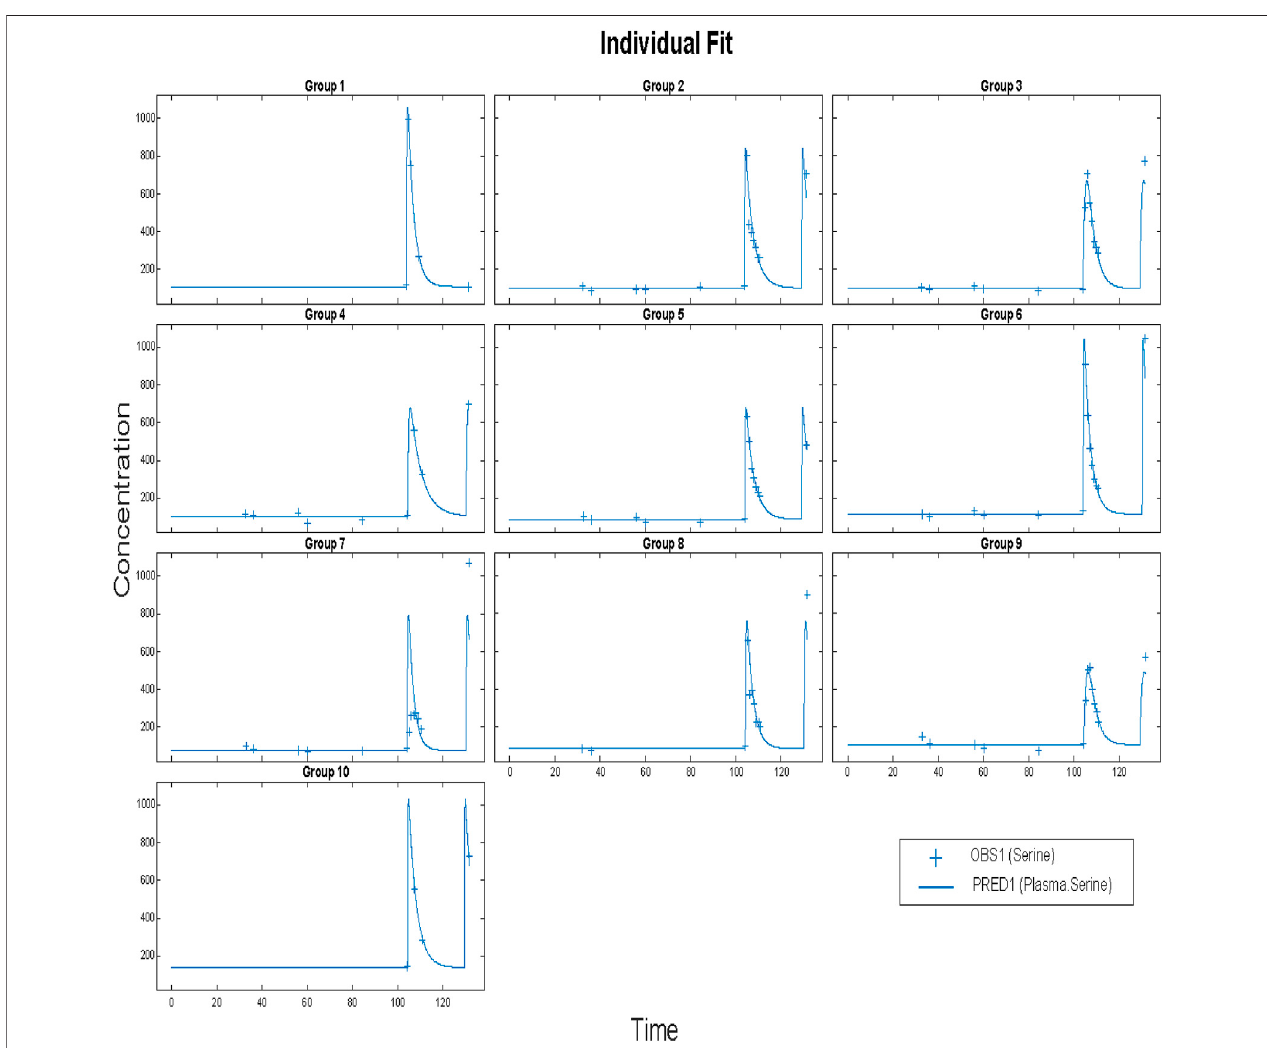
FIGURE 4 | Time vs concentration data and fi tted results. Each plot is an individual ’ s data. The range of concentrations (vertical lines) are from 0 to 1,000 umol/L. Each subject was fi tted individually, using a nonlinear least-squares routine with combined (constant plus proportional) error model in SimBiology ® . Clinical data (+) and model simulation (line).